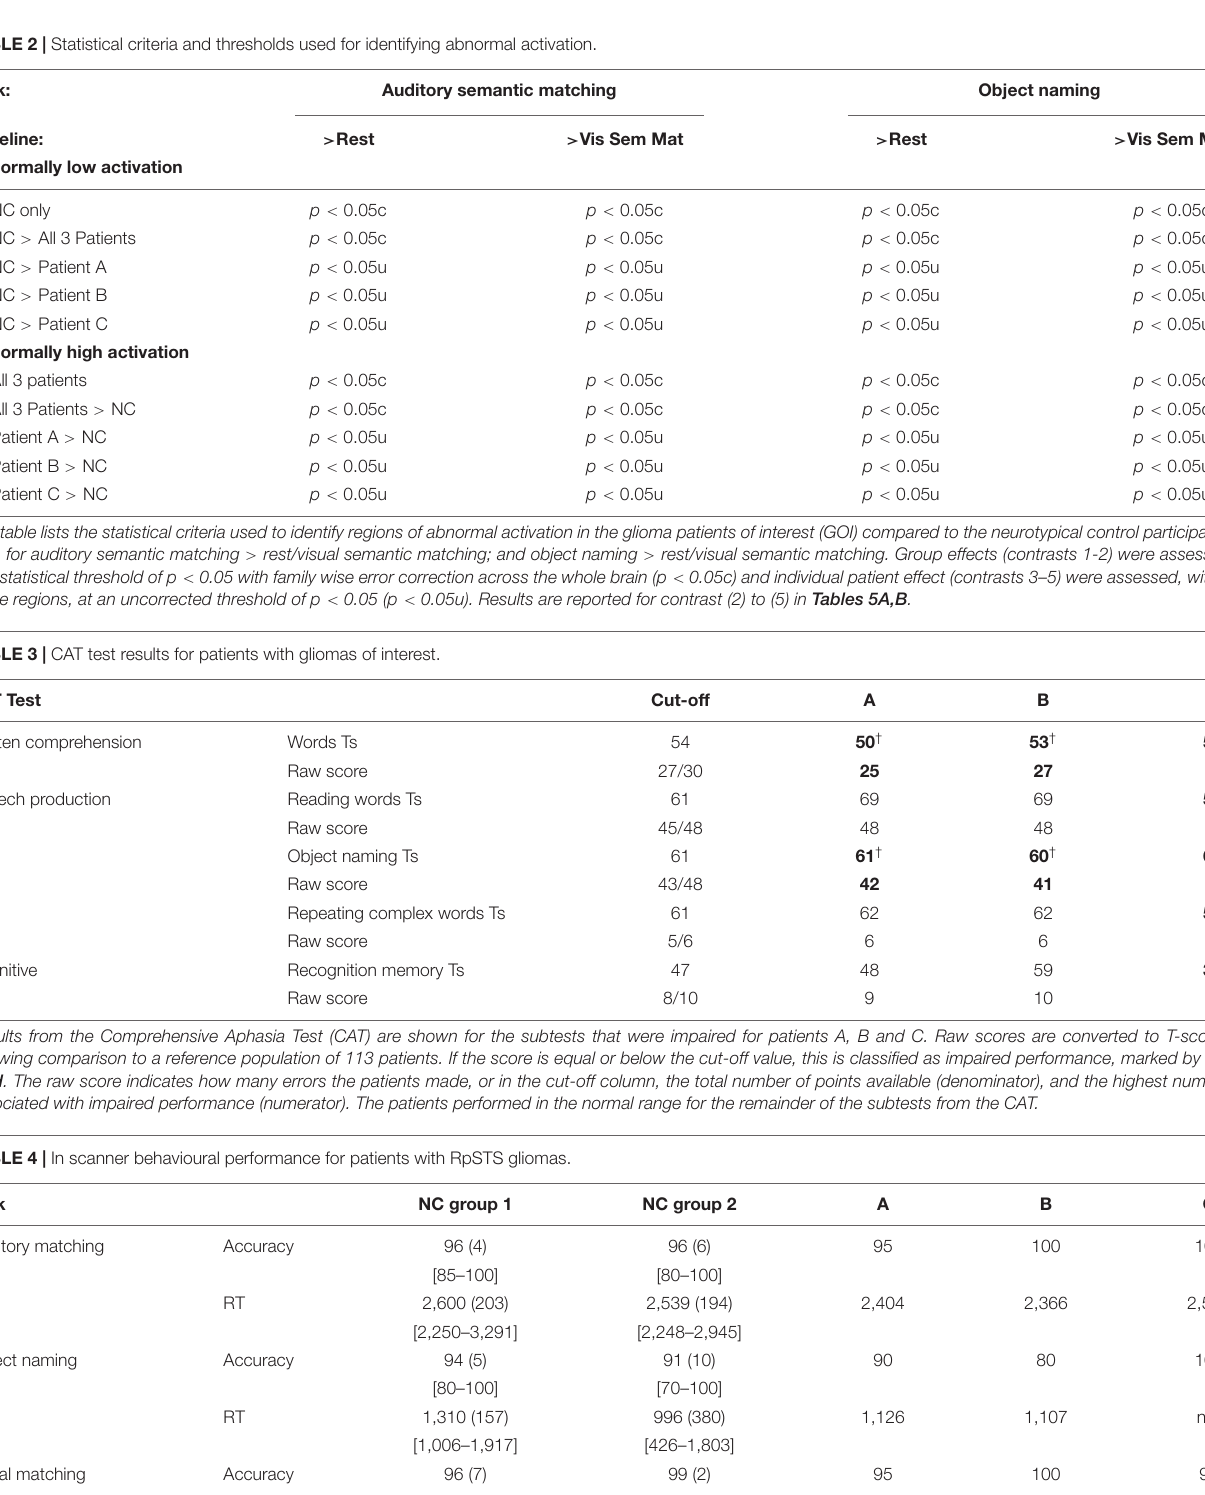
with (standard deviation) and [range]. n/a = not applicable because the response times could not be collected for technical reasons as detailed in the Materials and Methods section.